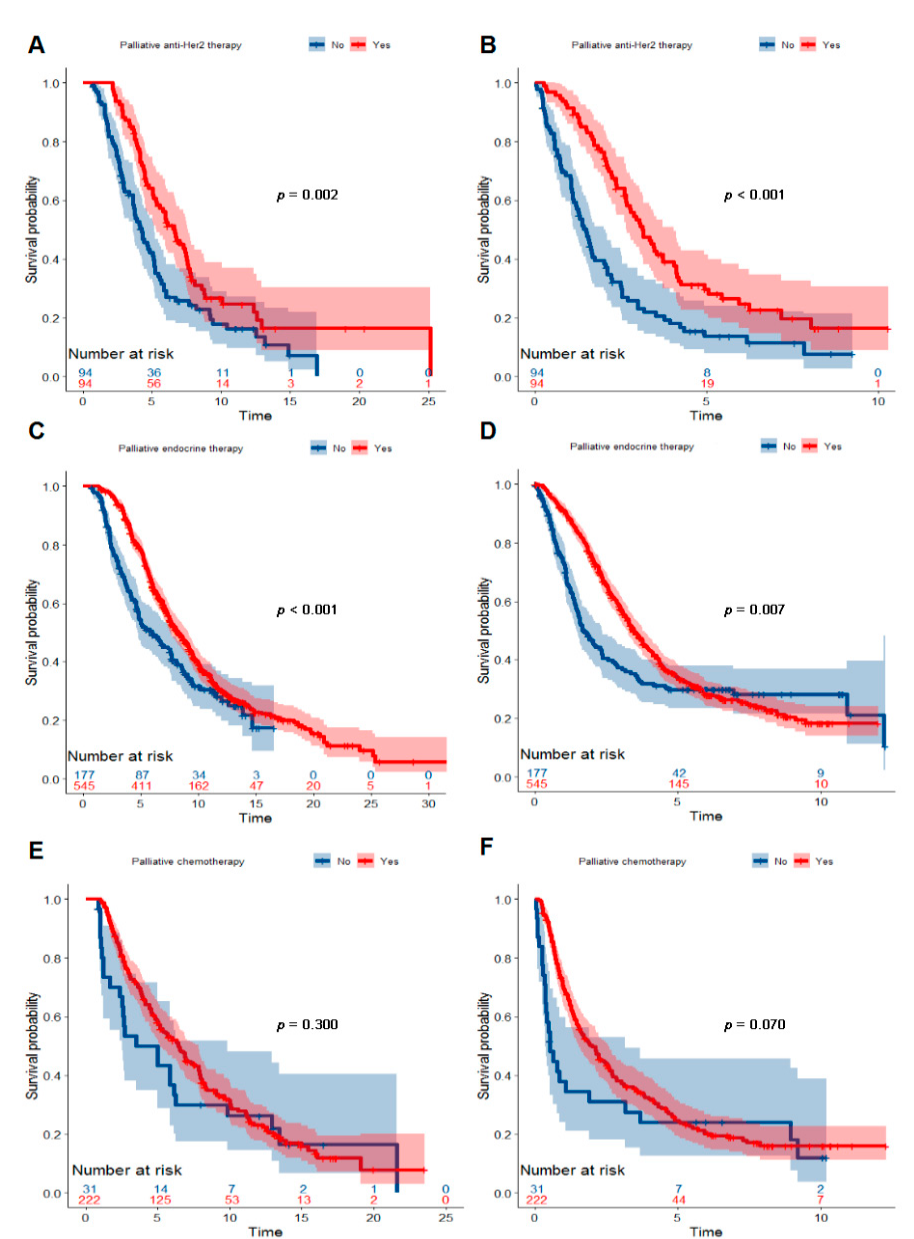
Figure 4. Kaplan–Meier curves showing a comparison of survival time among patients with breast cancer with BM according to molecular subtype and palliative treatment. Curves for OS ( A ) and OSABM ( B ) of patients with a Her2+ breast cancer stratified by palliative anti-Her2 therapy. Curves for OS ( C ) and OSABM ( D ) of patients with an ER+ breast cancer stratified by palliative endocrine therapy. Curves for OS € and OSABM ( F ) of patients with an ER-Her2- breast cancer stratified by palliative chemotherapy. Abbreviations: BM = bone metastasis; ER = estrogen receptor; Her2 = Human epidermal growth factor receptor 2; OS = overall survival; OSABM = overall survival after diagnosis of bone metastasis.